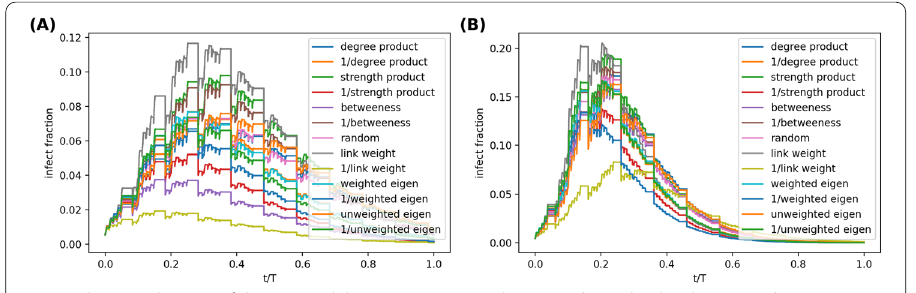
Fig. 1 The prevalence ρ of the SIR model over time in periodic network *HighSchool12 ( A ) and *WorkPlace15 ( B ), when mitigated via 13 contact blocking strategies defined by (1) respectively. The infection rate is β = 0.01 per time step, the recovery rate is γ = 1.22 ∗ 10 − 6 per time step, approximately 10% per day and 30% of the contacts are